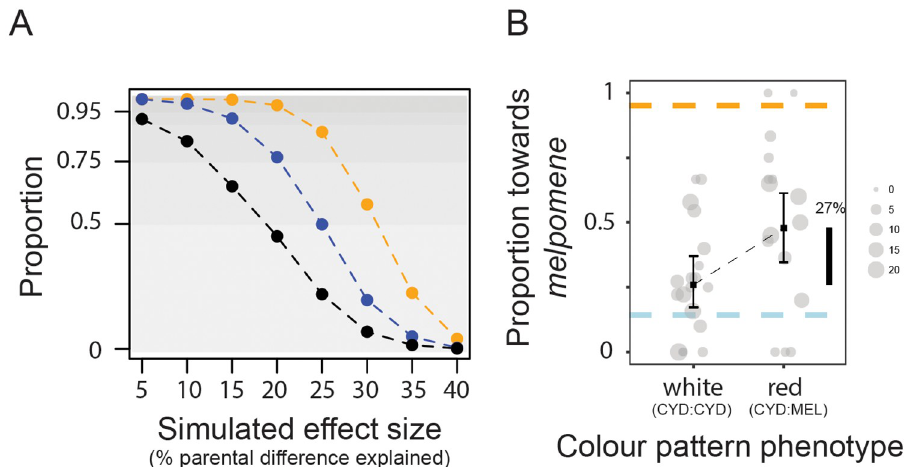
Fig 4. QTL effects in consideration of the Beavis effect. (A) Proportion of “significant” simulations that would be smaller than our empirically measured effects for preference QTLs on Chromosome 1 (blue), Chromosome 17 (black), and Chromosome 18 (orange). 10,000 simulations were run for effect sizes corresponding to between 5% and 40% of the difference in male preference behavior between the parental species. In each case, the distribution of sample effect sizes was determined for those simulations that reached the genome-wide significance threshold determined through permutation (Fig 2). Underlying data can be found in the online Dryad repository doi.10.5061/dryad.4b240j4, specifically derived_data/QTL_1_sim_results.csv, derived_data/QTL_17_sim_results.csv, and derived_data/ QTL_18_sim_results.csv. (B) Proportion of time males court H . melpomene (as opposed to H . cydno ) females for each of the two genotypes for white (homozygous = CYD:CYD) and red (heterozygous = CYD:MEL) hybrid males for which we were unable to generate RAD-seq data (so which were not included in our initial QTL analysis). Error bars represent 95% confidence intervals. Lower dashed blue and upper orange bars represent mean phenotypes measured in H . cydno and H . melpomene , respectively. Circle size depicts total number of “courtship minutes” for each male. Vertical black bars indicate the percentage of the difference measured in the parental species explained. Underlying data can be found in the online Dryad repository doi.10.5061/dryad.4b240j4, specifically raw_data/ IDs_with_pheno_no_RAD.csv. CYD, cydno allele; MEL, melpomene allele; QTL, quantitative trait locus; RAD-seq, restriction site–associated DNA sequencing.